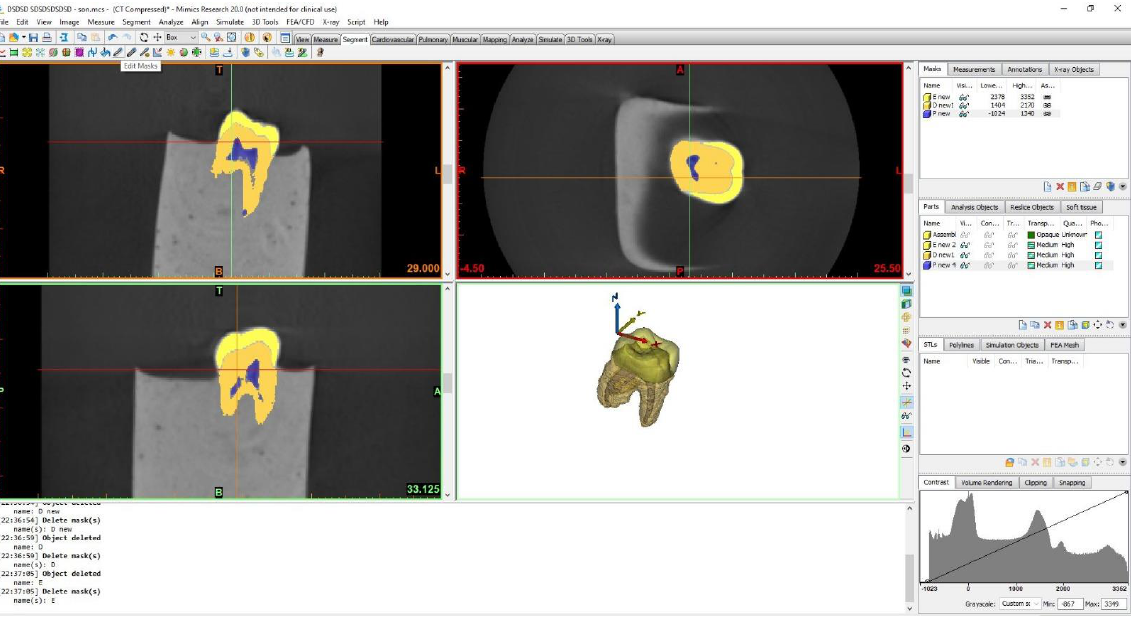
Figure 2. The three − dimensional model of the sound tooth was created manually in the Mimics program.